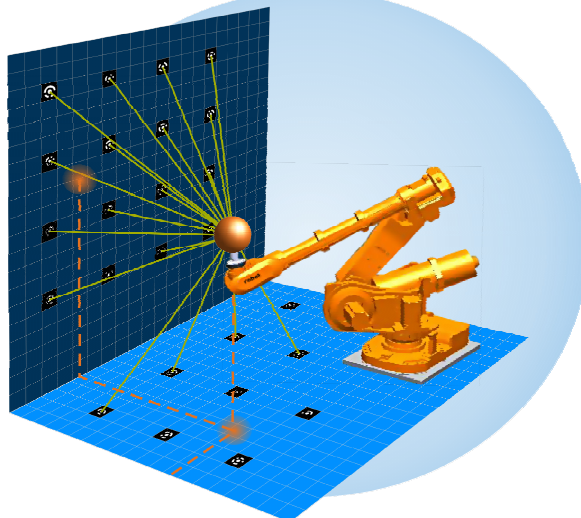
Figure 1. Pose estimation by a camera system observing surrounding reference